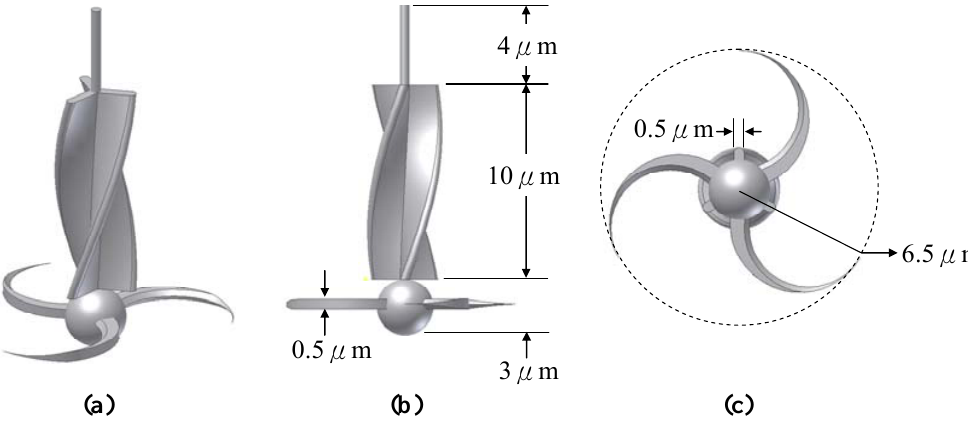
Figure 2. Dimension of the Archimedes screw-based micromachines: ( a ) 3-D view; ( b ) side view; ( c ) bottom view.